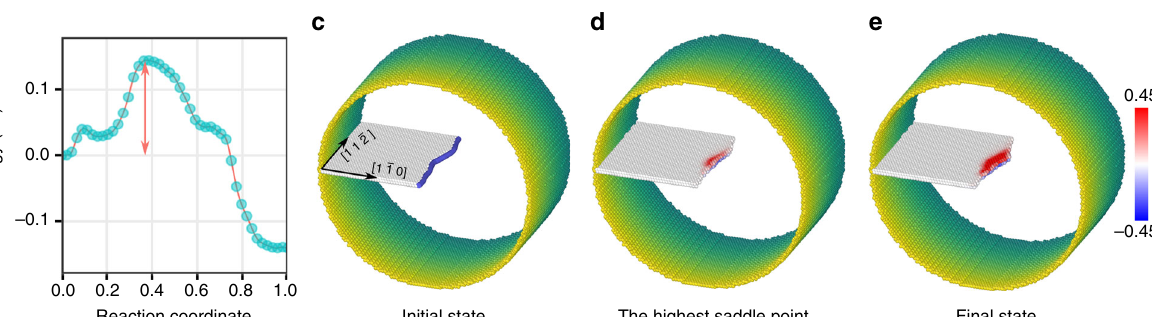
Fig. 4 Dislocation motion via nanoscale segment detrapping mechanism. a Correlated nanoscale processes for a leading partial dislocation (white color) in a sample with T a = 950 K. The applied temperature and shear stress are 300 K and 300 MPa, respectively. The swept areas between two neighboring snapshots/instants when the dislocation settles down brie fl y without motion (e.g., 20 and 60 ps) are highlighted in red. b – e The calculated minimum energy path of a nanoscale segment detrapping process, for a sample with T a = 950 K and subject to a local shear stress of 400 MPa. See Methods for calculation details. Reaction coordinates in b is the scaled hyperspace arc length. c shows the initial con fi guration with a curved leading partial dislocation (the blue tube). d shows the con fi guration corresponding to the highest saddle point in b , and e shows the fi nal con fi guration. For c – e , surface atoms are colored according to their positions along the axial direction and white atoms represent the complex stacking fault. The activated process of nanoscale segment detrapping during dislocation stick-slip motion is highlighted by the swept area as colored in red, based on the magnitude of atomic displacements along the axial direction. Numbers on the colorbar are in unit of